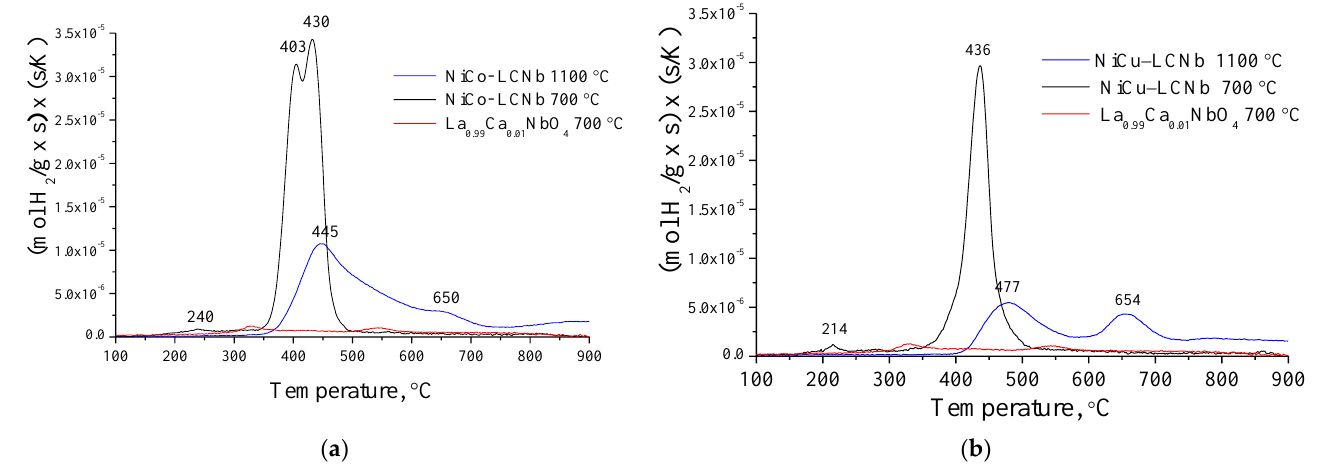
Figure 8. TPR-H 2 spectra of lanthanum orthoniobate LCNb and composites: ( a ) NiCo – LCNb and ( b ) NiCu – LCNb composites as powders sintered at 700 and 1100 °C. For both composites calcined at 1100 °C, reduction peaks are shifted to higher temperatures as compared with samples after calcination at 700 °C, while the amounts of removed oxygen decreases. Figure 9 shows the diffraction patterns of composites where, in addition to the main phase of lanthanum orthoniobate, phases of NiCo and NiCu alloys are obtained. Hydrogen consumption during NiCo – LCNb composite reduction is larger than that for NiCu – LCNb, as displayed in Table 2.